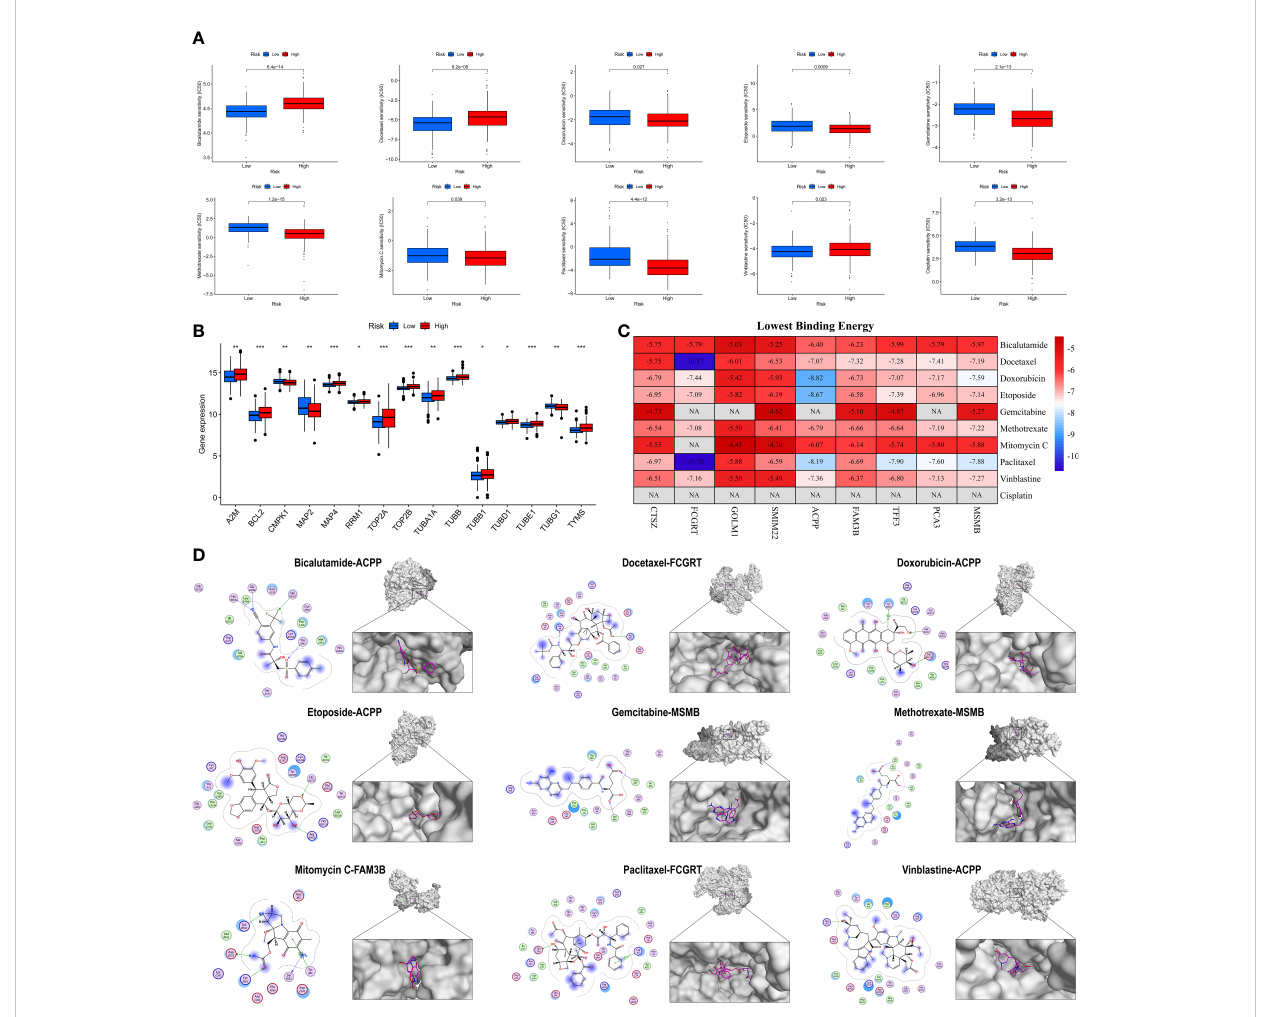
FIGURE 11 Evaluation of anti-PCa drugs based on MRMGPS. (A) Comparison of 10 anti-PCa drugs sensitivity (IC50) between high- and low-risk groups. (B) Comparison of the expression pro fi le of 10 anti-PCa drugs targeted genes between high- and low-risk groups. (C) Heatmap displaying the lowest binding energy of 10 anti-PCa drugs docking with MRMGPS-based genes. (D) 2D (left) or 3D (right) binding mode of 10 anti-PCa drugs to the MRMGPS-based genes with the lowest binding energy. * P < 0.05, ** P < 0.01, *** P <